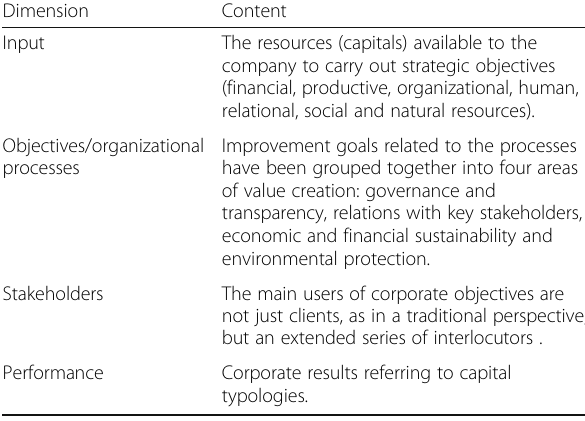
Table 4 Costa Edutainment ’ s business model dimensions